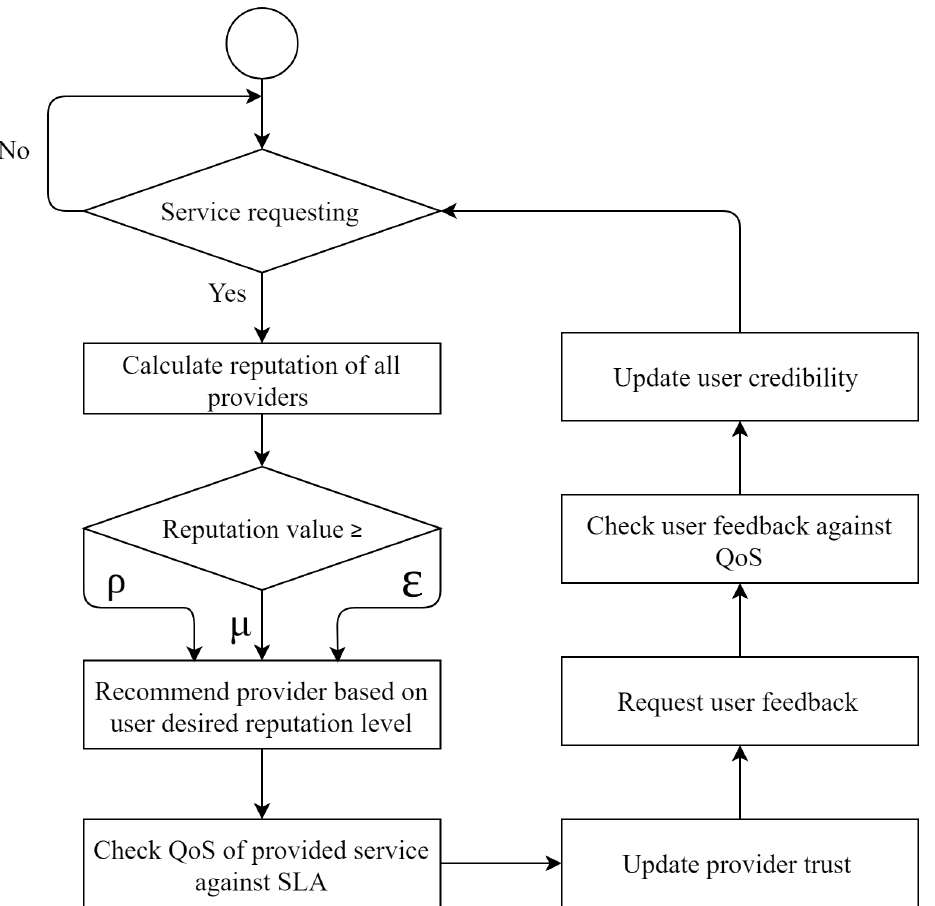
Figure 3. HealthyBroker